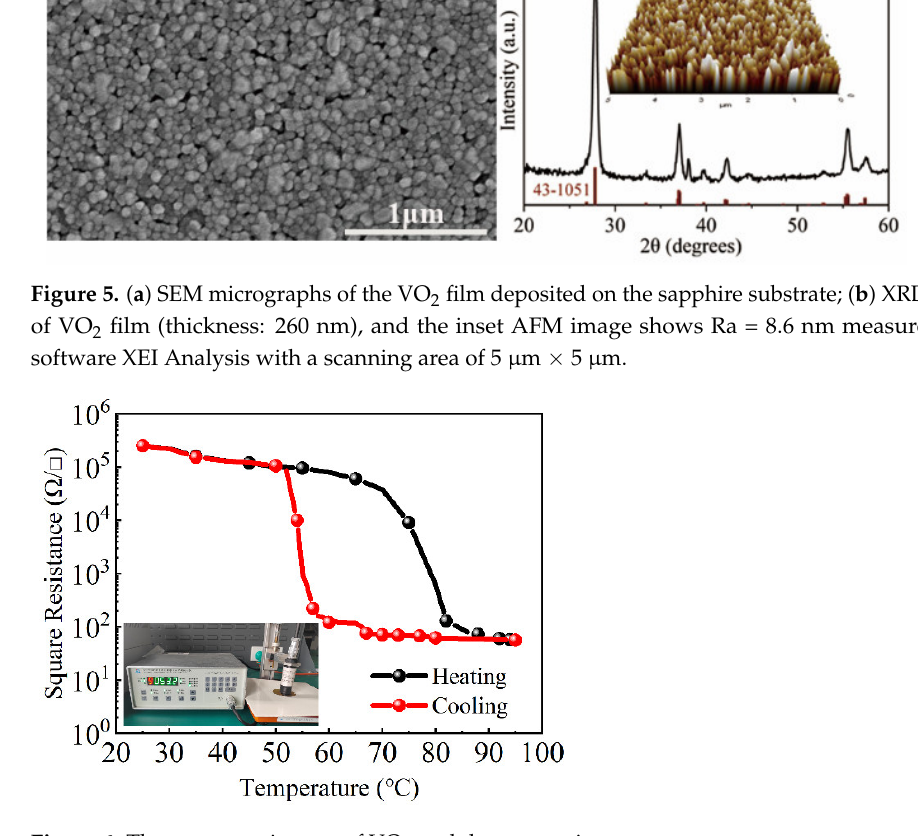
Figure 5. ( a ) SEM micrographs of the VO 2 film deposited on the sapphire substrate; ( b ) XRD patterns of VO 2 film (thickness: 260 nm), and the inset AFM image shows Ra = 8.6 nm measured by the soft- ware XEI Analysis with a scanning area of 5 μm × 5 μm.